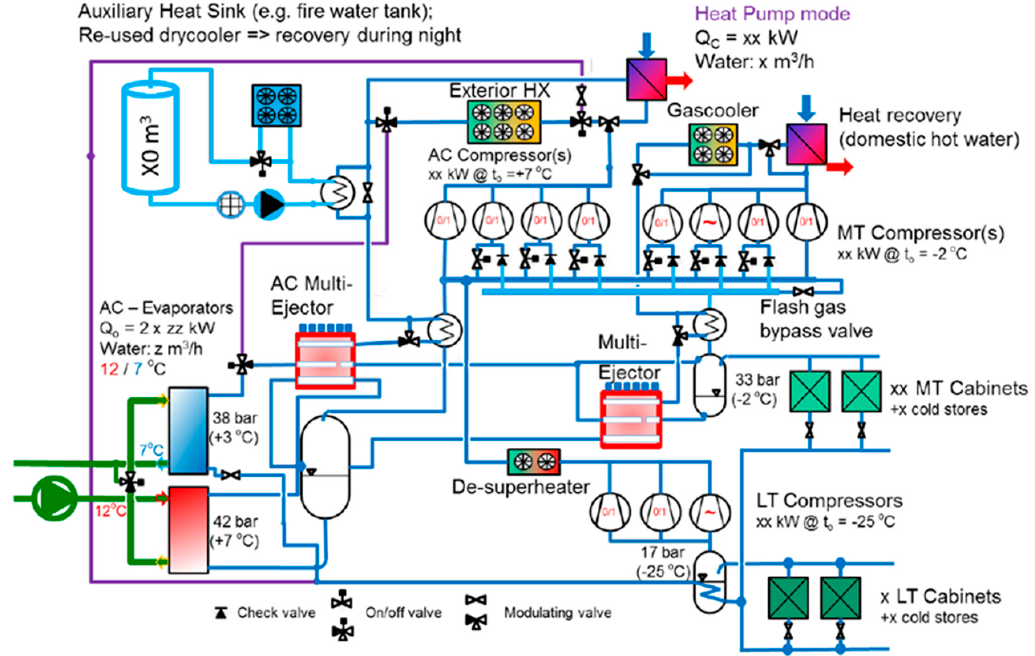
Figure 7. Fully-integrated R744 multi-ejector enhanced parallel compression system suitable for supermarkets located in warm areas [40].